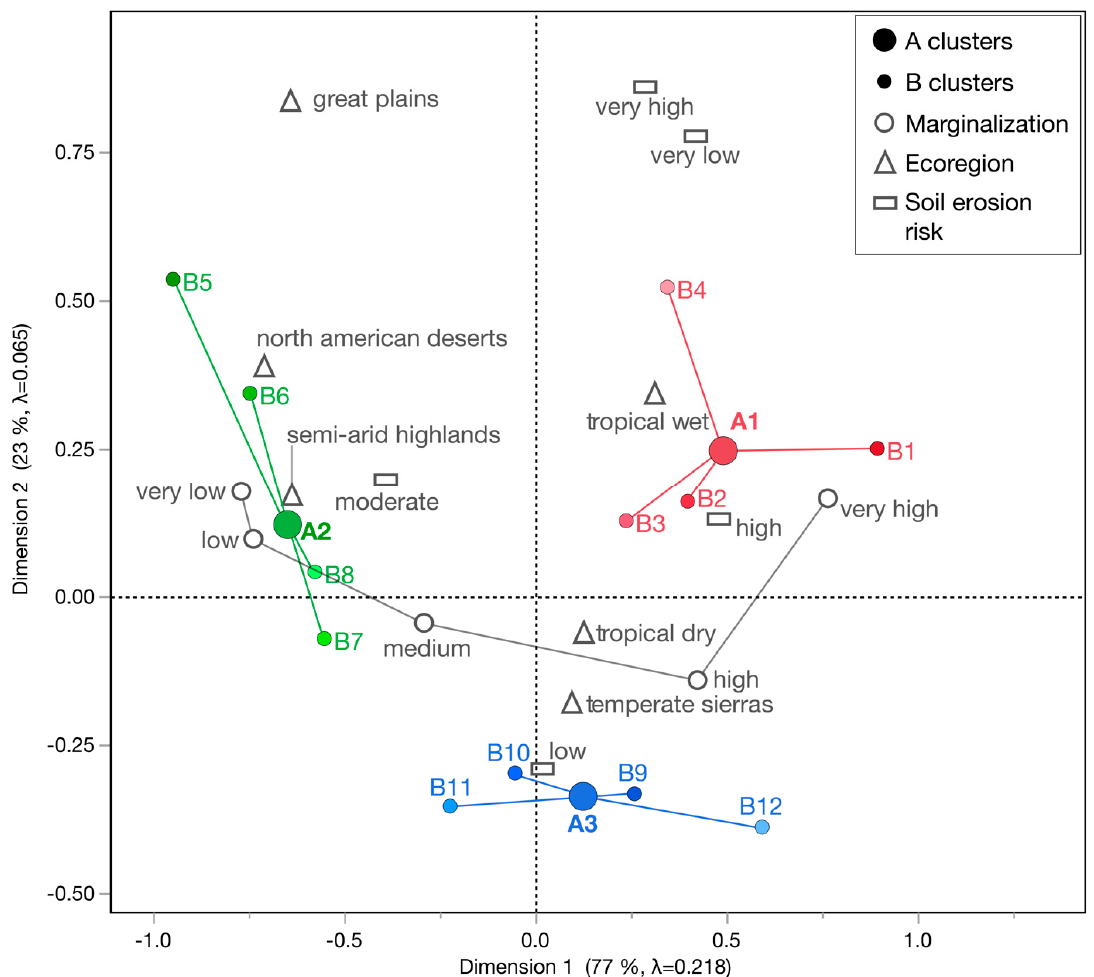
Figure 5. Correspondence plot for Clusters (A) (row), marginalization level (column) and soil erosion risk level (column). Clusters (B) and ecoregion are supplementary variables.